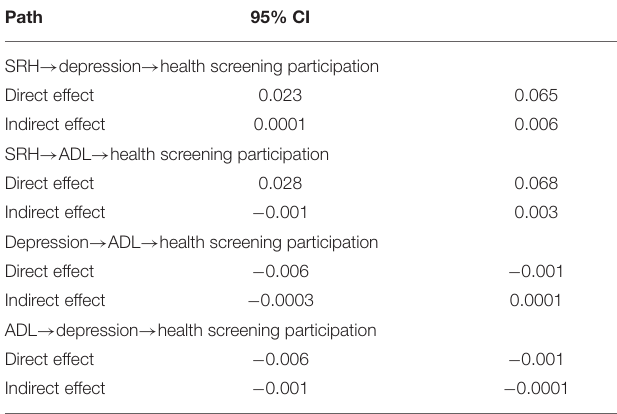
TABLE 3 | Bootstrapping test results for mediation